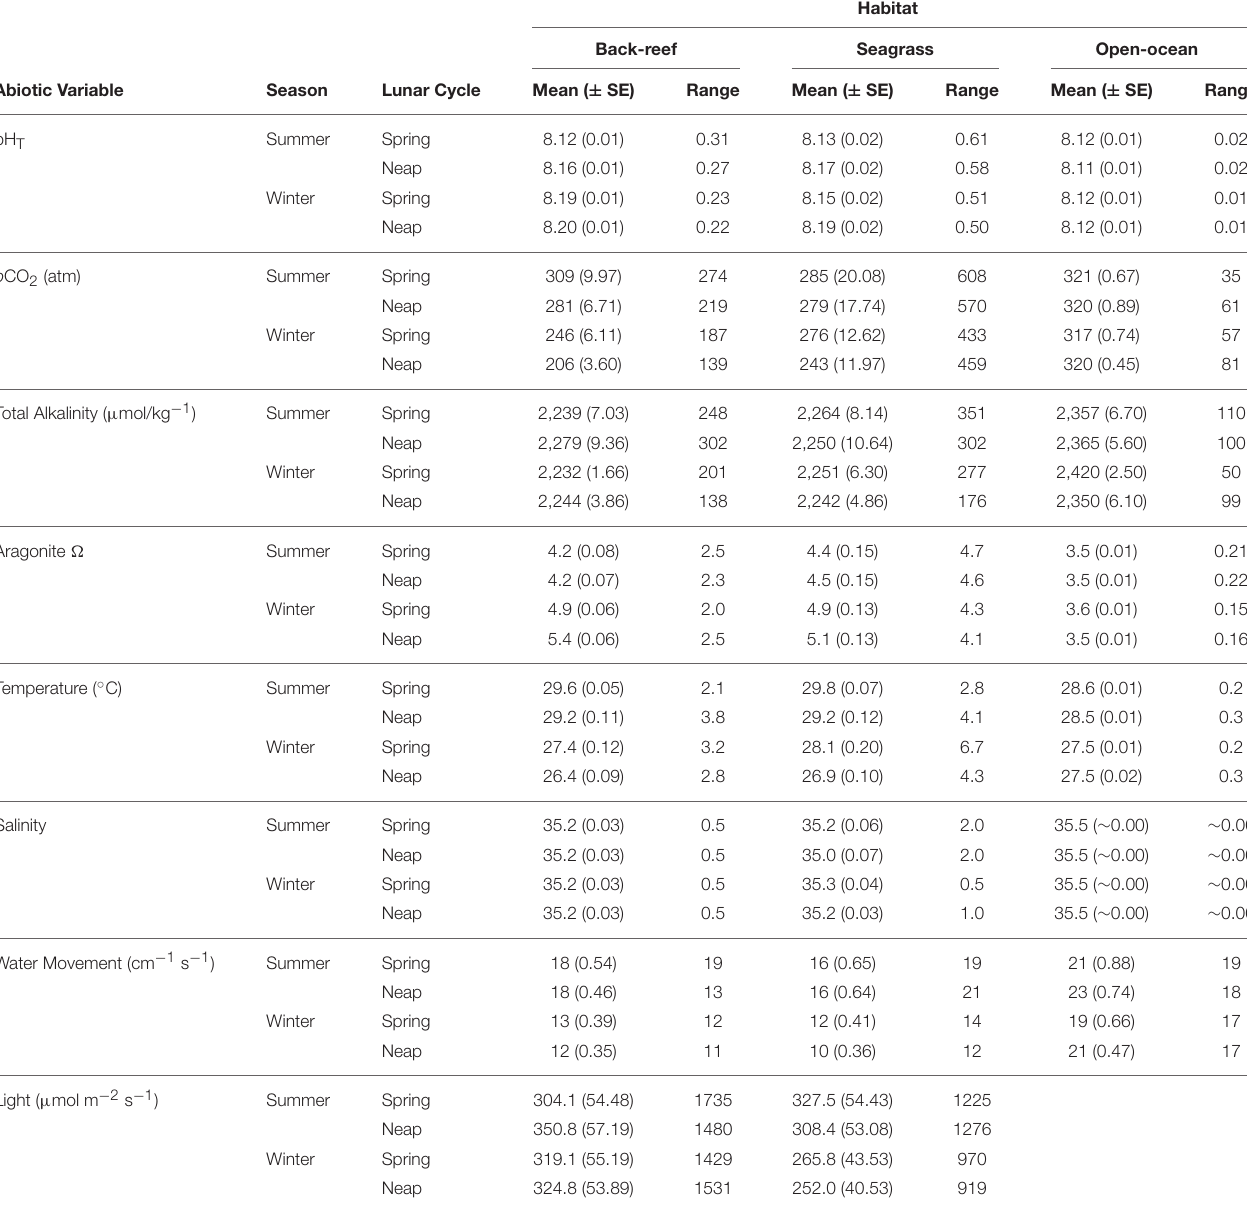
TABLE 1 | Physicochemical data for the seagrass and back-reef habitats on Little Cayman, Cayman Islands, British West